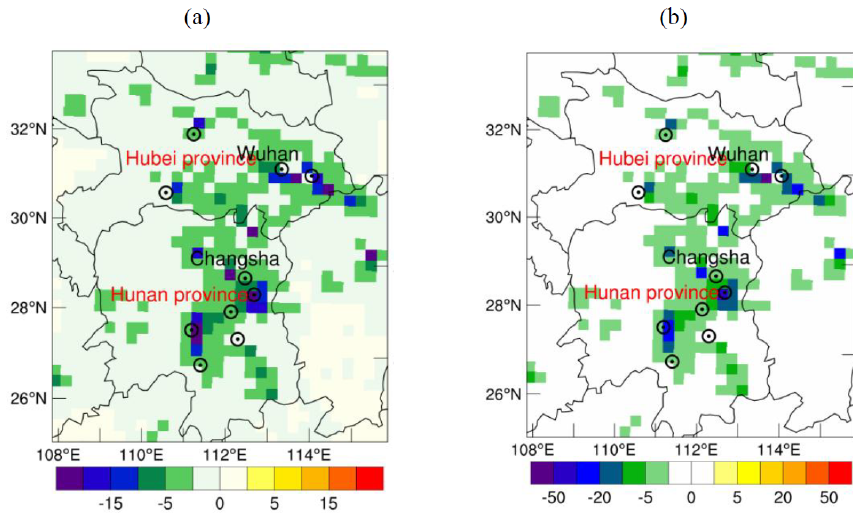
Figure 9. (a) Difference between 2020 and 2019 emissions, and (b) ratios of (2020–2019) / 2019 emissions in central China. Black circles with dots are the location of large cities. The red characters are the name of provinces, and the black characters are the name of cities. Wuhan and Changsha are the capitals of Hubei and Hunan provinces, respectively. Units: molkm − 2 h − 1 for (a) and percent (%) for (b) .